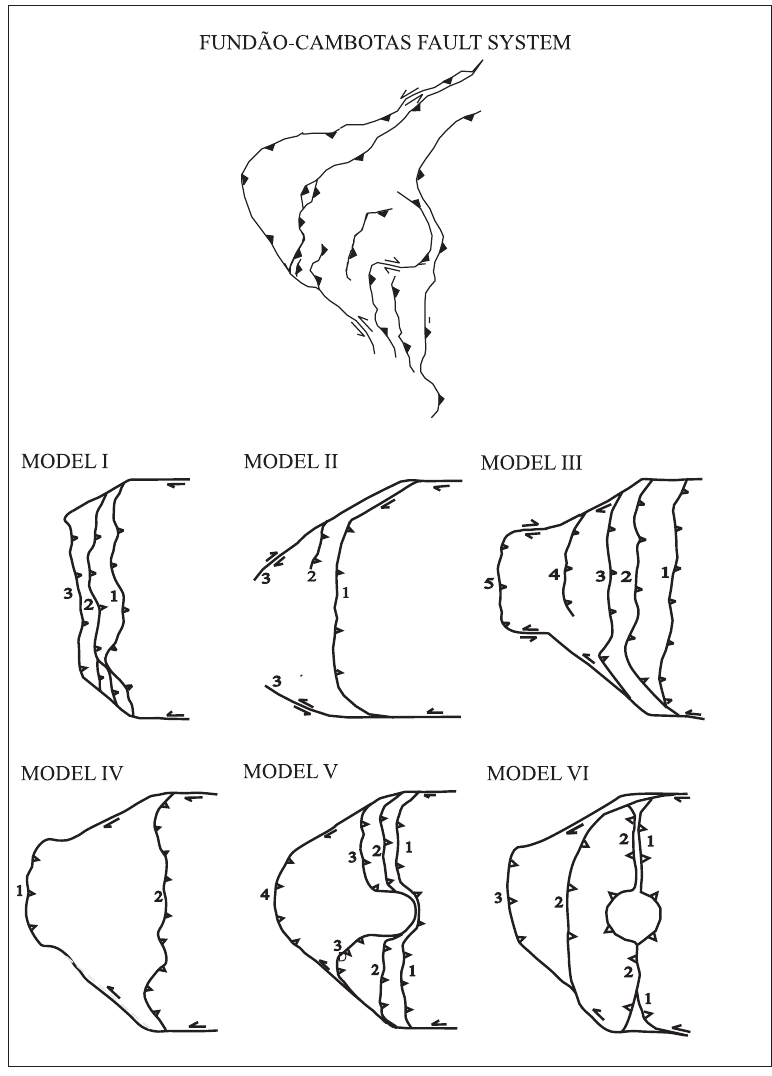
Fig. 9 – Simplified structural map of the Fundão-Cambotas Fault System and the results of sandbox models I to